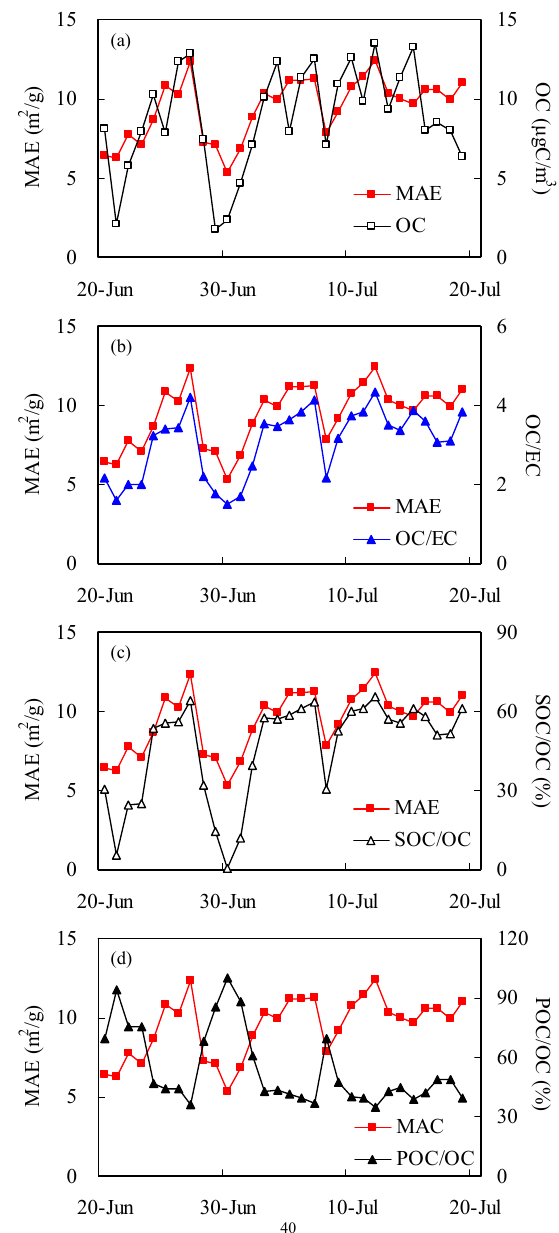
Fig. 2. Daily variation of MAE in Beijing during summer. The daily pattern of OC concentration (a) , OC to EC ratio (b) , percentage of SOC in OC (c) , and percentage of POC in OC (d) are also shown for